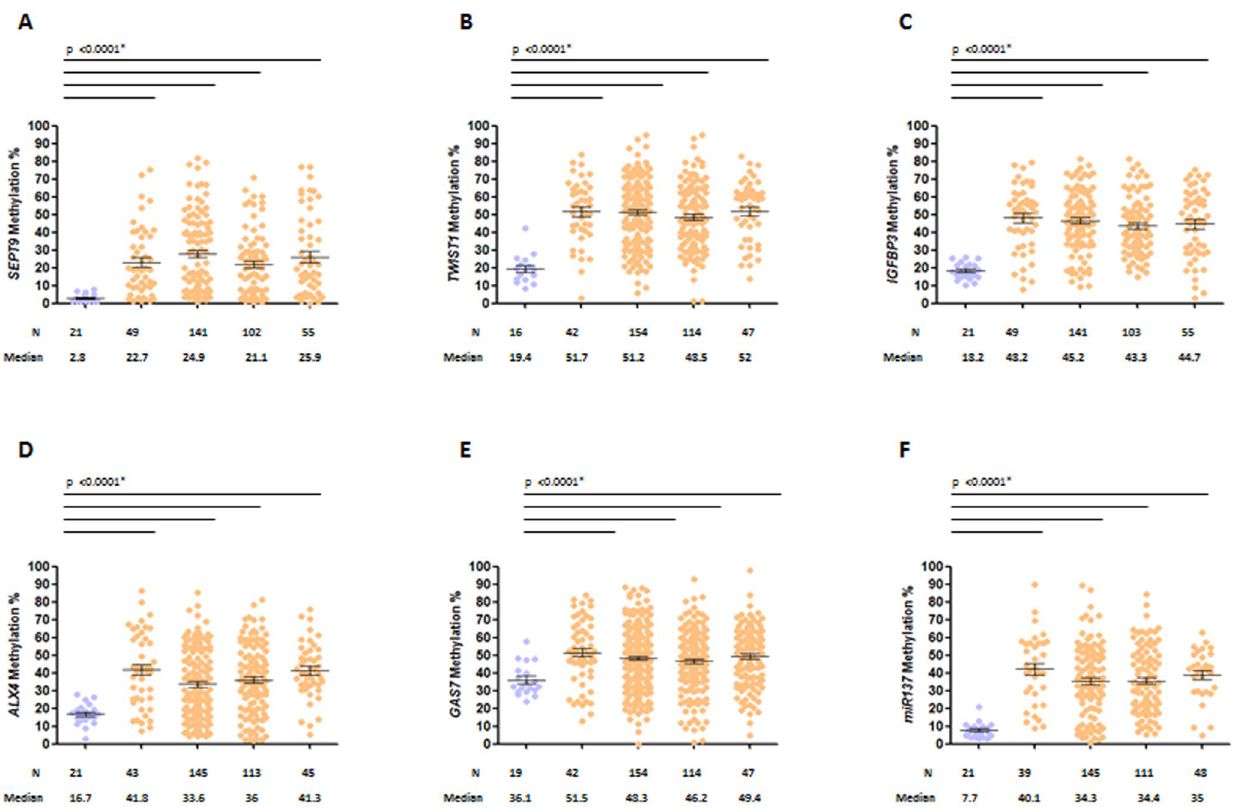
Figure 2. Levels of methylation in normal colonic mucosa and crc tumors from all tnm stage patients. Bisulfite pyrosequencing results of methylation of sept9 (a), twist1 (b), igfbp3 (c), alx4 (d), gas7 (e) and mir137 (f) comparing normal mucosa from healthy patients (n-n) and primary